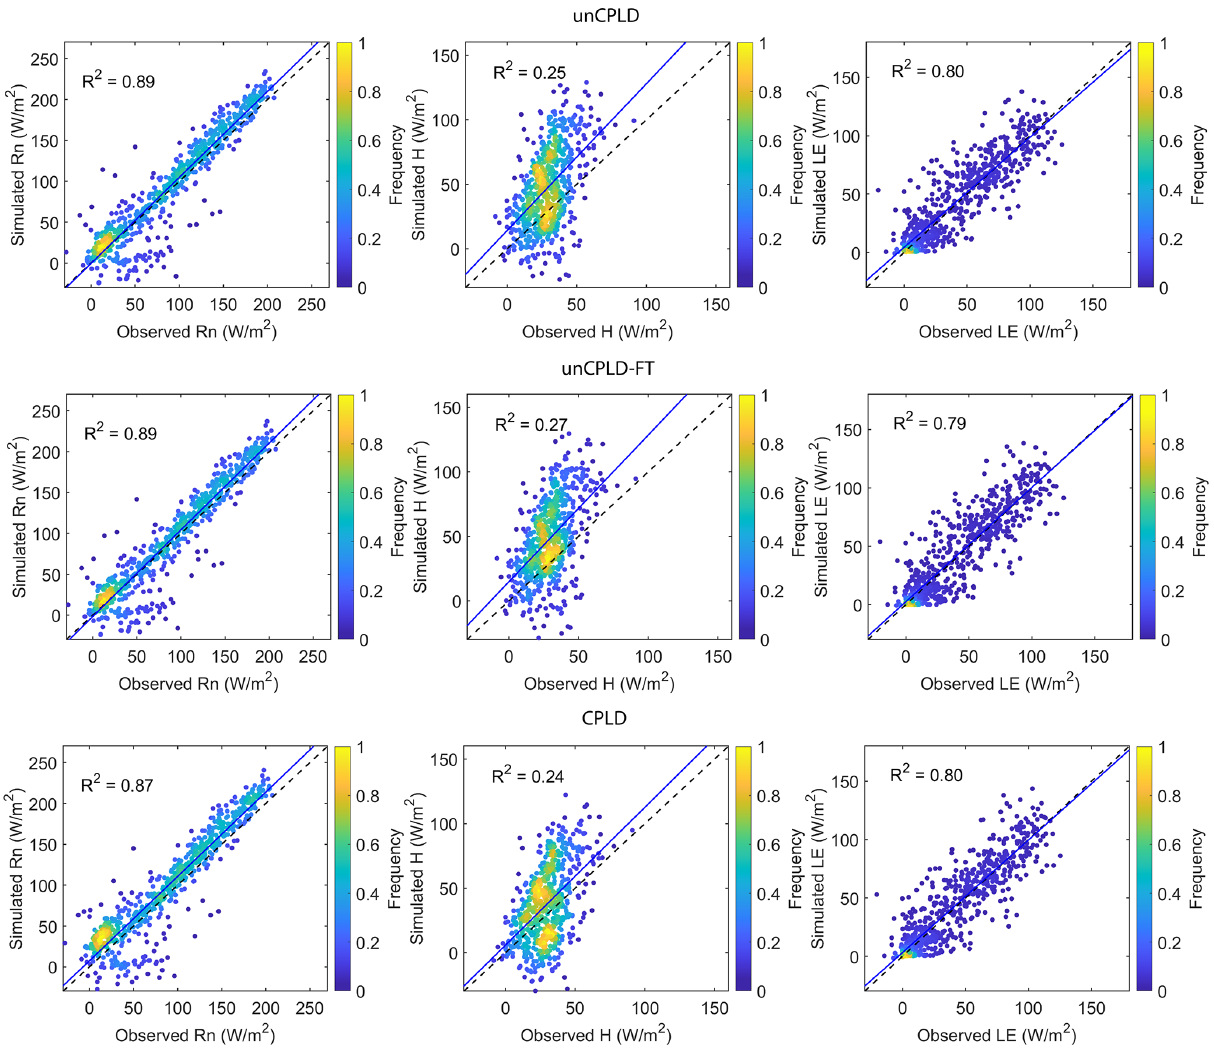
Figure 5. Scatter plots of observed and model-simulated daily average surface fluxes (net radiation: Rn; latent heat: LE; and sensible heat flux: H ) using the original (uncoupled) T&C (unCPLD), T&C with consideration of the FT process (unCPLD-FT), and coupled T&C and STEMMUS (CPLD) models, with the color indicating the frequency of surface flux